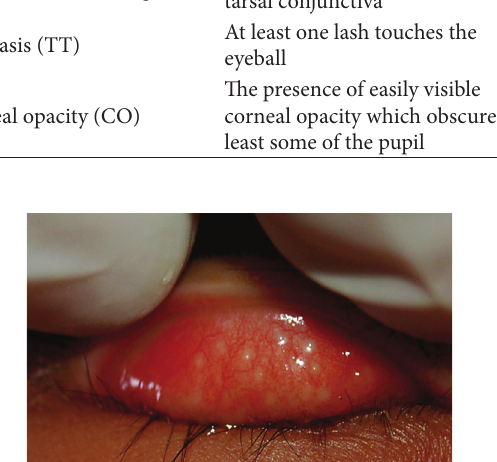
Figure 7: Inflammatory trachoma (TI stage). Figure courtesy of Hollman Miller, Vaup´es, Colombia.